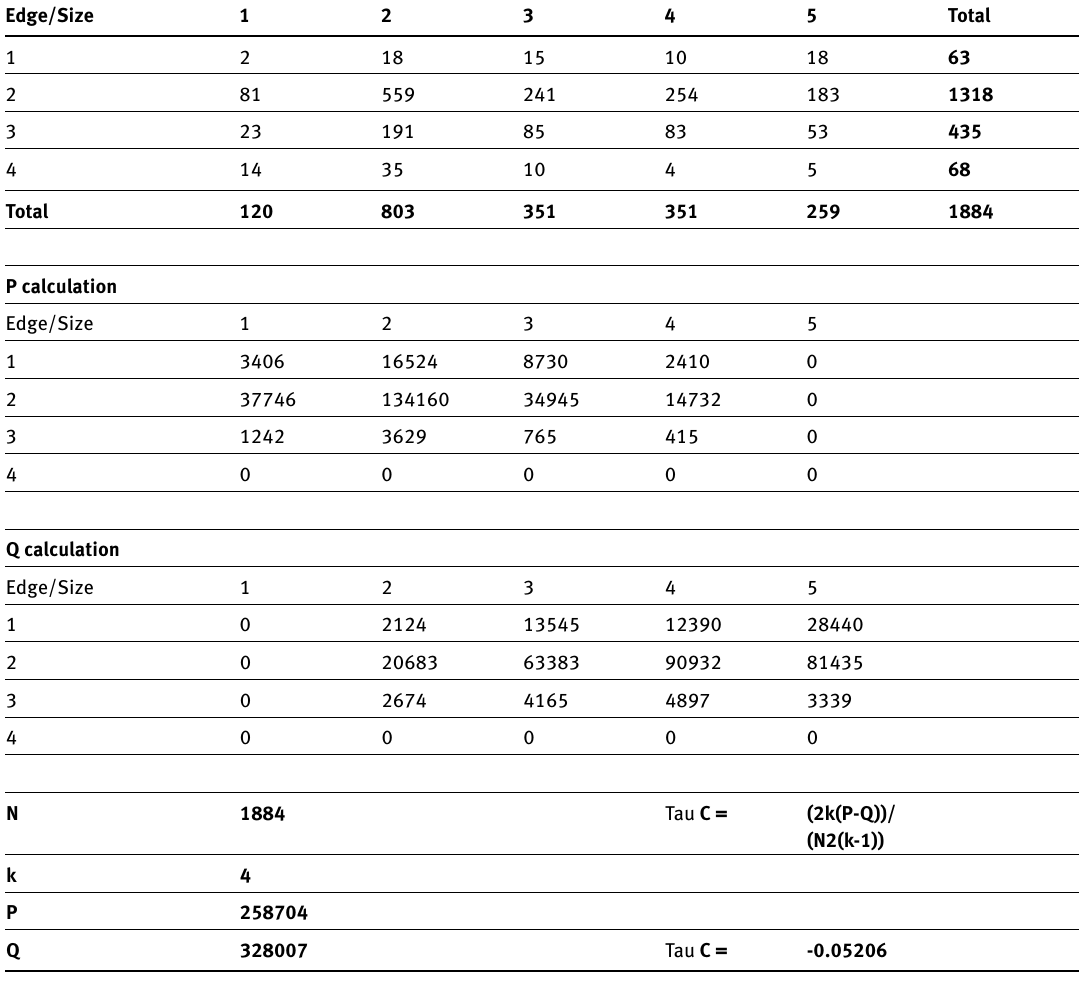
Table 5. Calculation of Kendall’s Tau C correlation, for ceramic sherds from layers only with a substantial quantity of ceramic sherds, and direct relevance to the phases of occupation ( i.e. layers 1.2, 1.3, and 1.5). Equation as detailed for Table